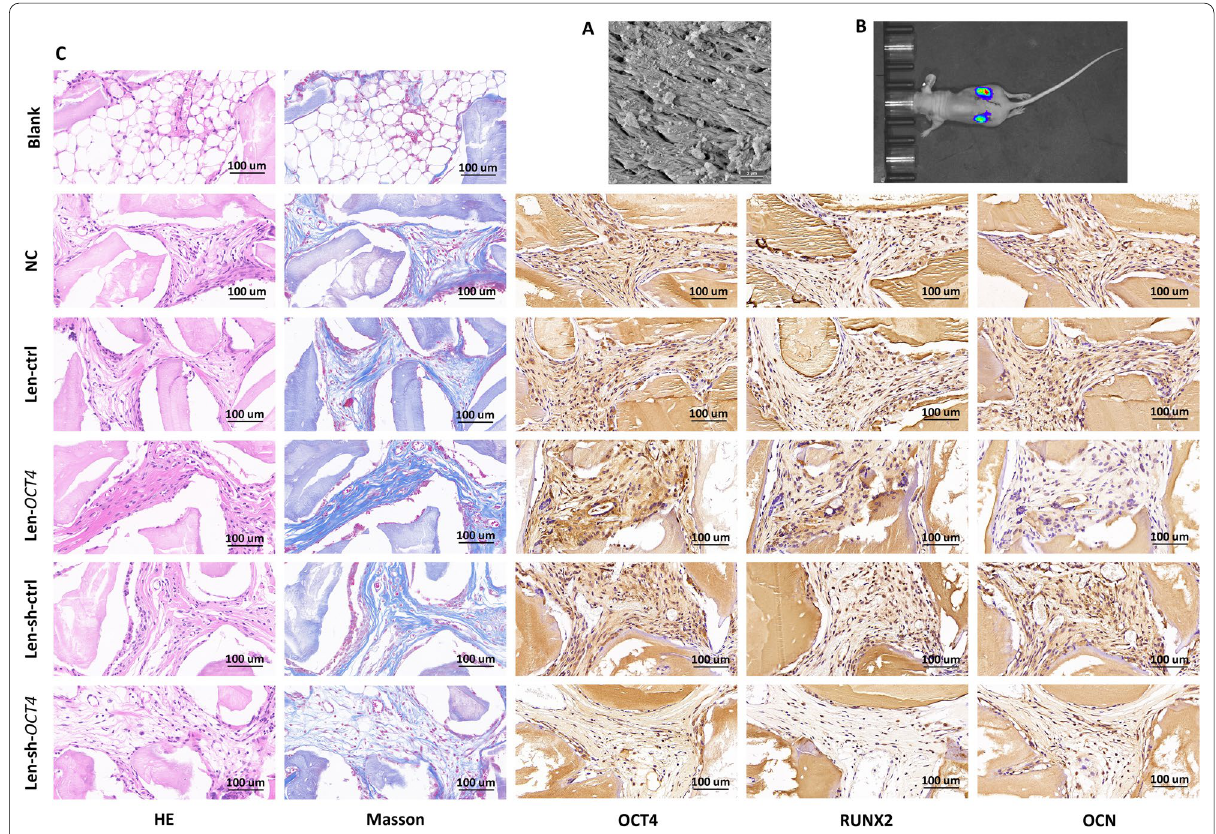
Fig. 3 OCT4 enhanced osteogenic-like differentiation of human renal interstitial fibroblasts (hRIFs) in vivo. A The porous structure of bone mineral substitute granules visualized by scanning electron microscopy (X20000). B A representative fluorescence image of a nude female mouse 8 weeks after subcutaneous implantations carrying transfected hRIFs expressing luciferase (n 3). C HE and Masson staining of serial sections from the = blank group (granules without cells), the normal control (NC) group (granules with hRIFs), the Len-ctrl group (granules with hRIFs transfected with Len-ctrl), and the Len- OCT4 group (granules with hRIFs transfected with Len- OCT4 ), Len-sh-ctrl group (granules with hRIFs transfected with Len-sh-ctrl) and the Len-sh- OCT4 group (granules with hRIFs transfected with Len-sh-OCT4). IHC (OCT4; RUNX2; OCN) staining of serial sections from the NC group, the Len-ctrl group and the Len- OCT4 group, Len-sh-ctrl group, and the Len-sh- OCT4 group. Each of the 6 groups was implanted in 1 subcutaneous site of 6 mice and collected 8 weeks after